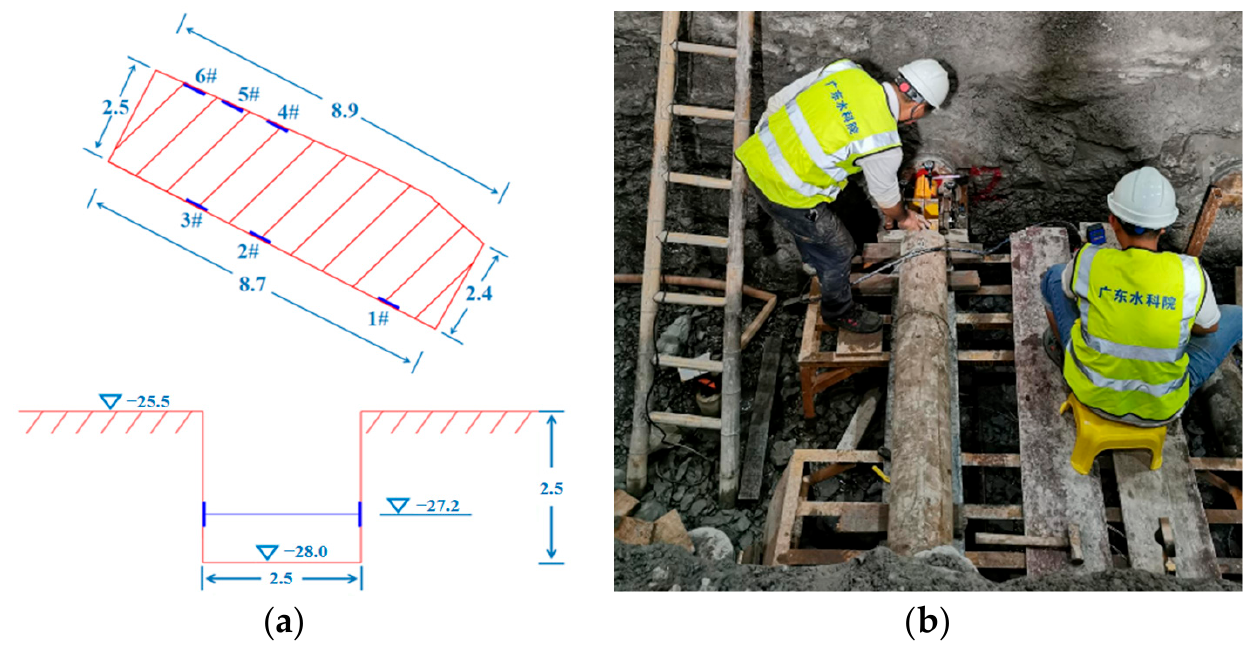
Figure 2. In situ pressure plate test. ( a ) Site layout. ( b ) Field loading test. By measuring the surface deformation of the rock mass using a pressure plate test, the deformation modulus was calculated. And the deformation modulus of the borehole deformation test was compared. The test pit was located in a weakly weathered pelitic siltstone layer. The lithology of the six test points is relatively complete; weakly weathered pelitic siltstone without obvious fracture development. Under two stress levels of water delivery pressure of 0.7 MPa and a maximum test pressure of 2.1 MPa, the secant and fitting methods were used to compare and analyze the deformation modulus. The calculated deformation modulus at the highest point of the test pressure is shown in Table 1. Table 1. Deformation modulus of each test